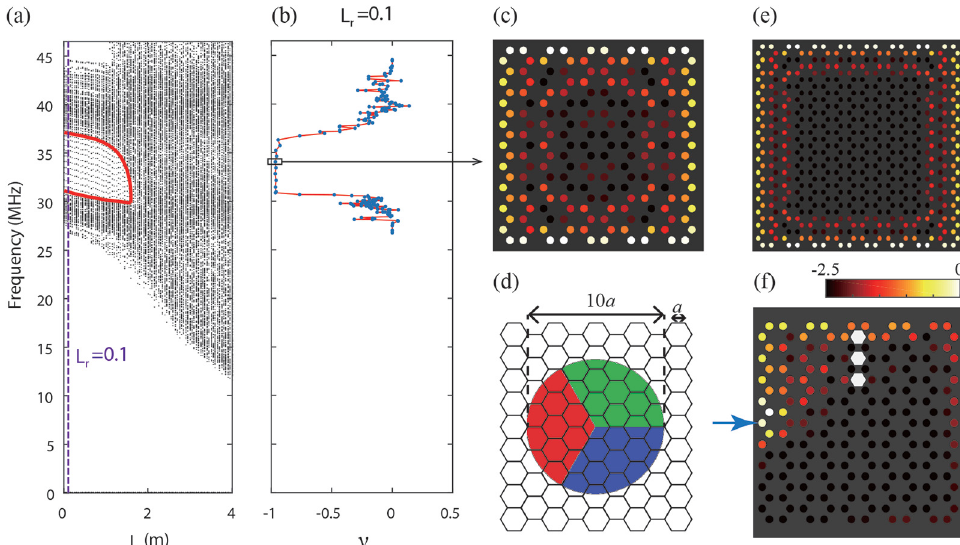
Fig. 2. (a) Energy spectrum vs. the disorder strength parameter L r . The red line marks the topological non-trivial gap which closes gradually as L r increases. The states inside the gap are localized on the edges. (b) The computed local Chern numbers as a function of frequency for L r = 0.1, which is marked by the dotted line in panel (a). In the gap region, the local Chern number is close to (cid:3) 1. (c) The fi eld pattern of an edge state in the gap marked by the arrow in (b). (d) The computational domain is a 9 (cid:4) 9 fi nite-sized sample. The red/blue/green highlights the 3 sectors used in the local Chern number computation. (e) The edge state pattern of a larger sample with 15 rows by 15 columns for L r =0.1. (f) The one-way propagating edge wave in a sample with an inserted